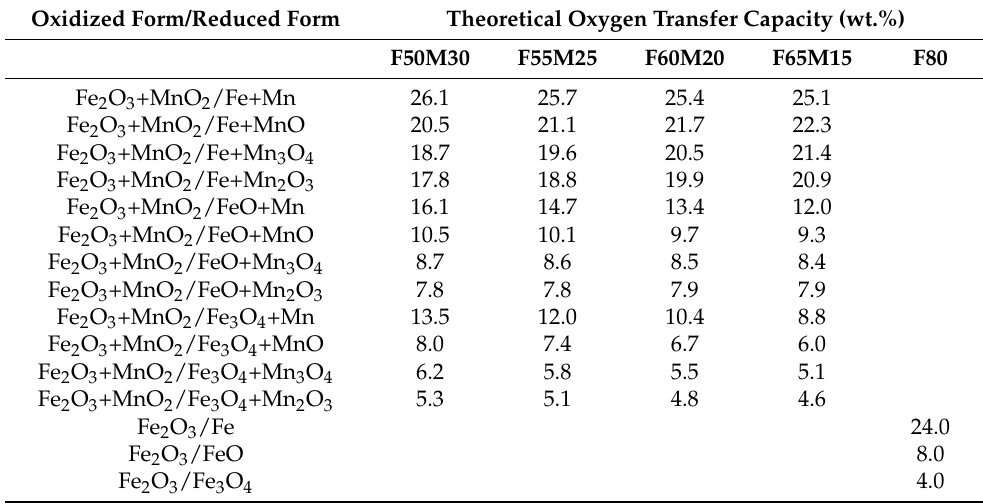
Table 3. Predicted oxygen transfer capacity of the oxygen carriers under different reduction